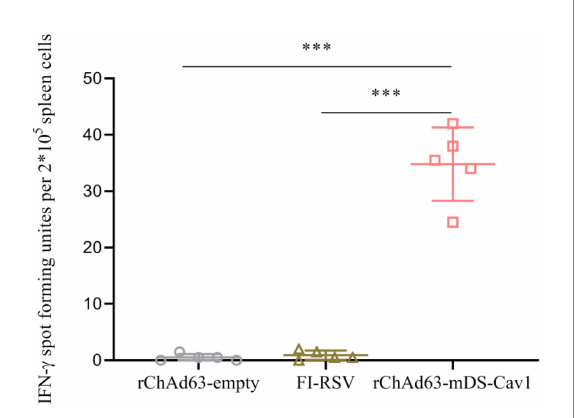
FIGURE 5 Specific CD8+ T cell responses after immunization with rChAd63-mDS-Cav1. BALB/c mice ( n = 5) were immunized intranasally with rChAd63-mDS-Cav1, and RSV F-specific CD8+ T cell responses were detected by ELISpot on the 21st day after immunization. Data were shown as mean ± SD, *** p < 0.001.